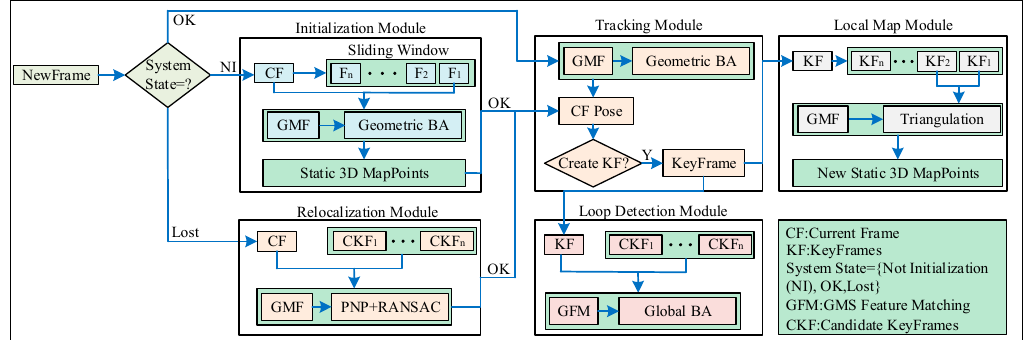
Figure 2. The system architecture diagram of DMS-SLAM. Our pipeline consists of initialization, tracking, local map, loop detection and relocalization module. System initialization is achieved according to NewFrame in the initialization module. The current frame pose estimation and keyframes are obtained in the tracking module after system is successfully initialized. In the local map module, a static local map is constructed according to key frames in the tracking module. When the system detects the closed-loop, it enters the loop detection module to optimize the global pose and map points and when the system tracking is lost, the relocalization module is entered to perform the current frame pose estimation.